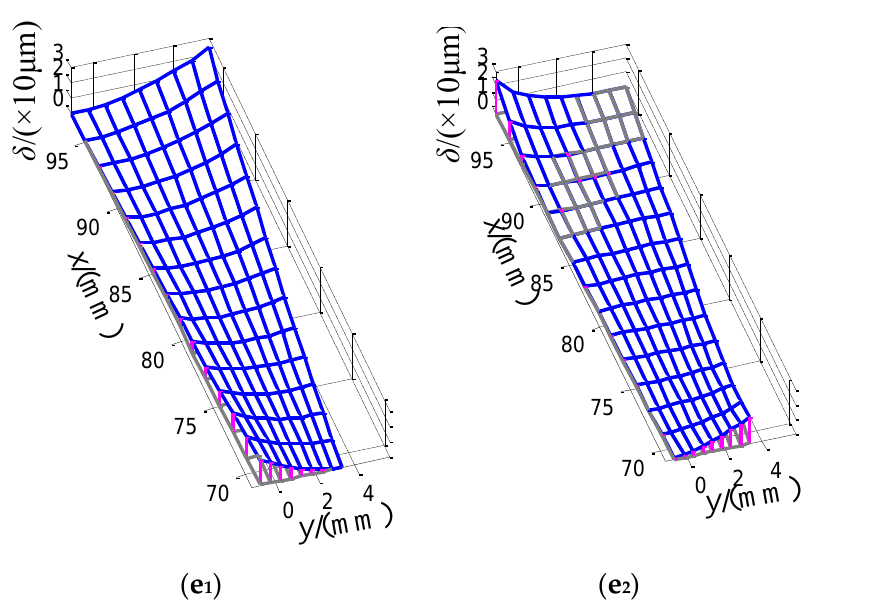
Figure 5. TCA simulation and ease-off deviation. (a) TCA for the theoretical tooth. (b) TCA for the best ease-off tooth. (c) TCA for the conjugate tooth. (d) The ease-off deviation for the theoretical tooth. (e 0 ) The best ease-off deviation for the optimization tooth. (e 1 ) The ease-off deviation, dependent only on the length of the instantaneous contact line. (e 2 ) The ease-off deviation, dependent only on the transmission error.